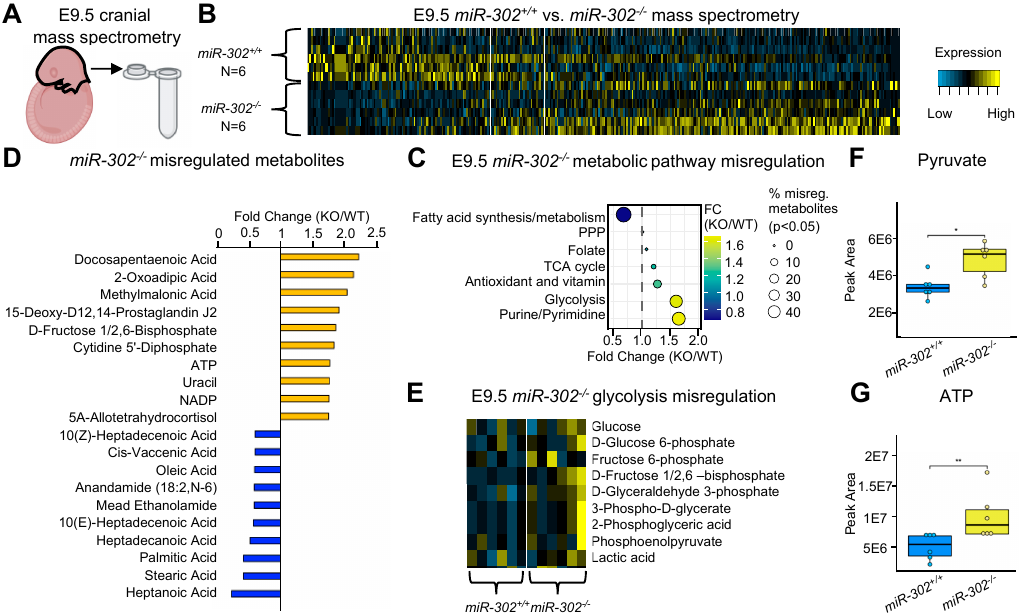
Figure 4. Loss of miR-302 leads to accumulation of glycolytic intermediates. ( A ) Schematic showing sample collection for mass spectrometry. ( B ) Heatmap of global misregulation of metabolites upon miR-302 deletion. ( C ) Dot plot showing how metabolic pathways were changed in the miR-302 knockout. ( D ) Bar plot of the top significantly up- and downregulated metabolites. ( E ) Heatmap showing the upregulation of the glycolysis pathway. ( F ) Boxplot showing upregulation of pyruvate and ( G ) ATP in the miR-302 knockout.